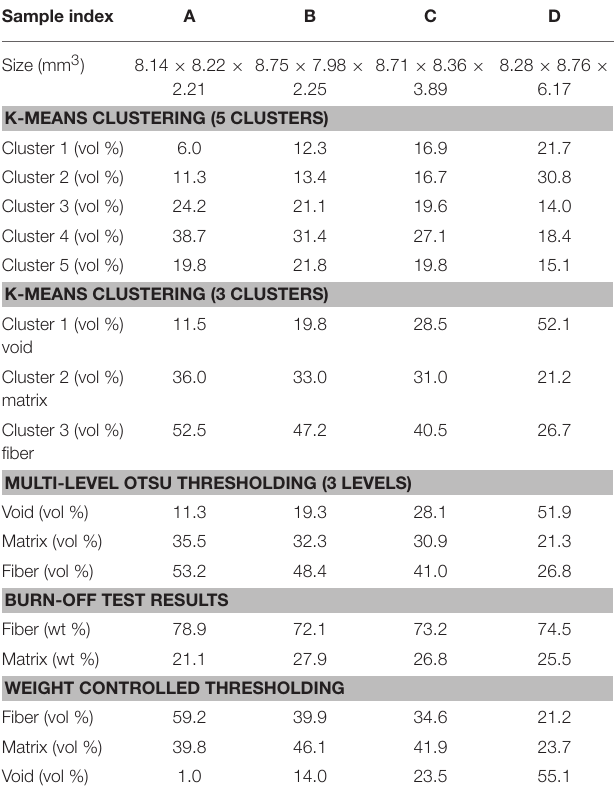
TABLE 3 | Volume fractions of the segmented µ CT images according to the K-means clustering and to the weight-controlled-methods. Sample